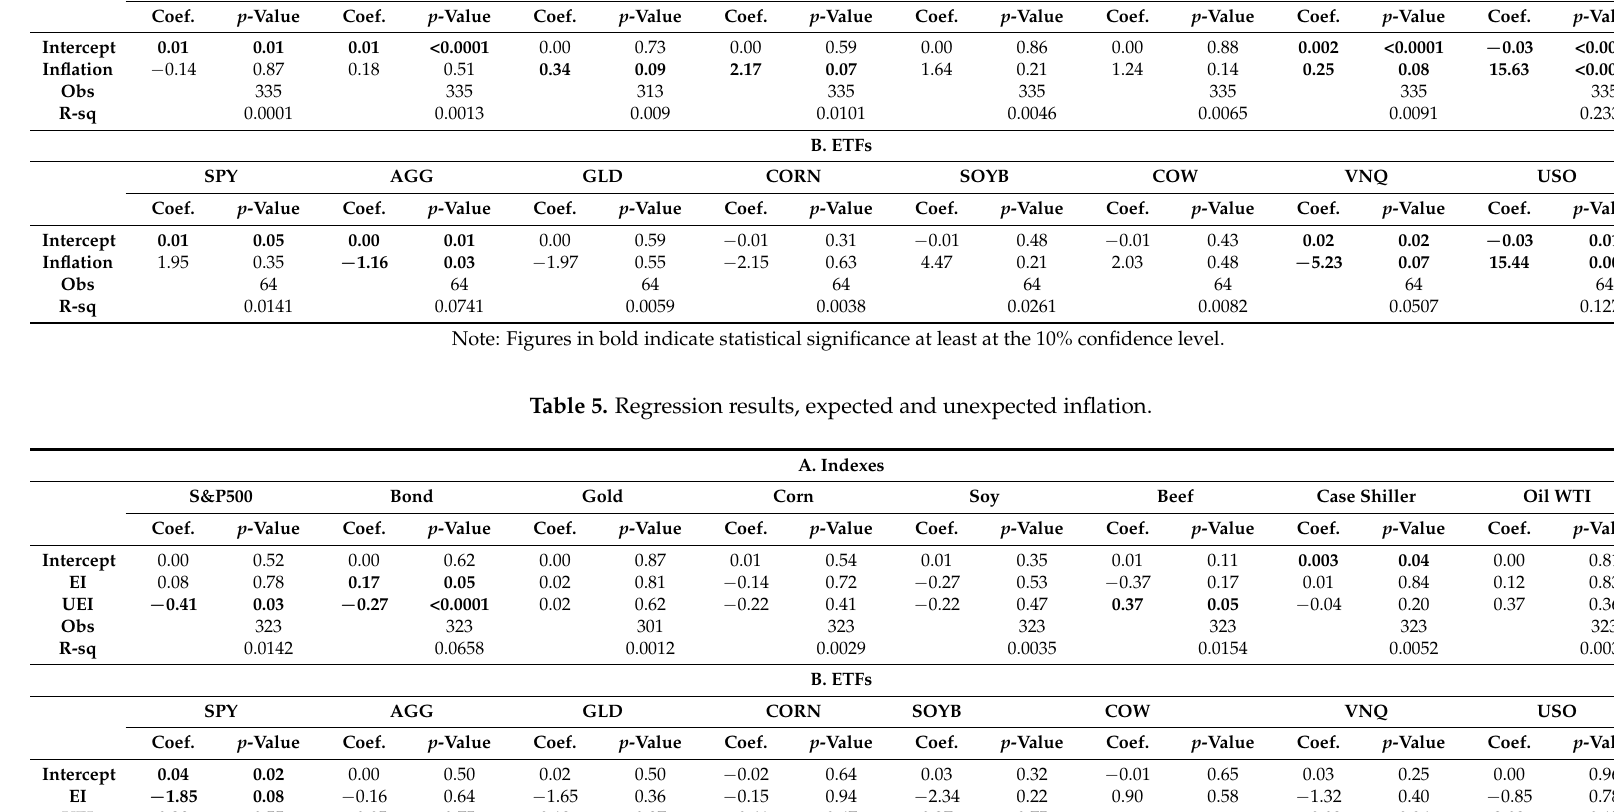
Note: Figures in bold indicate statistical significance at least at the 10% confidence